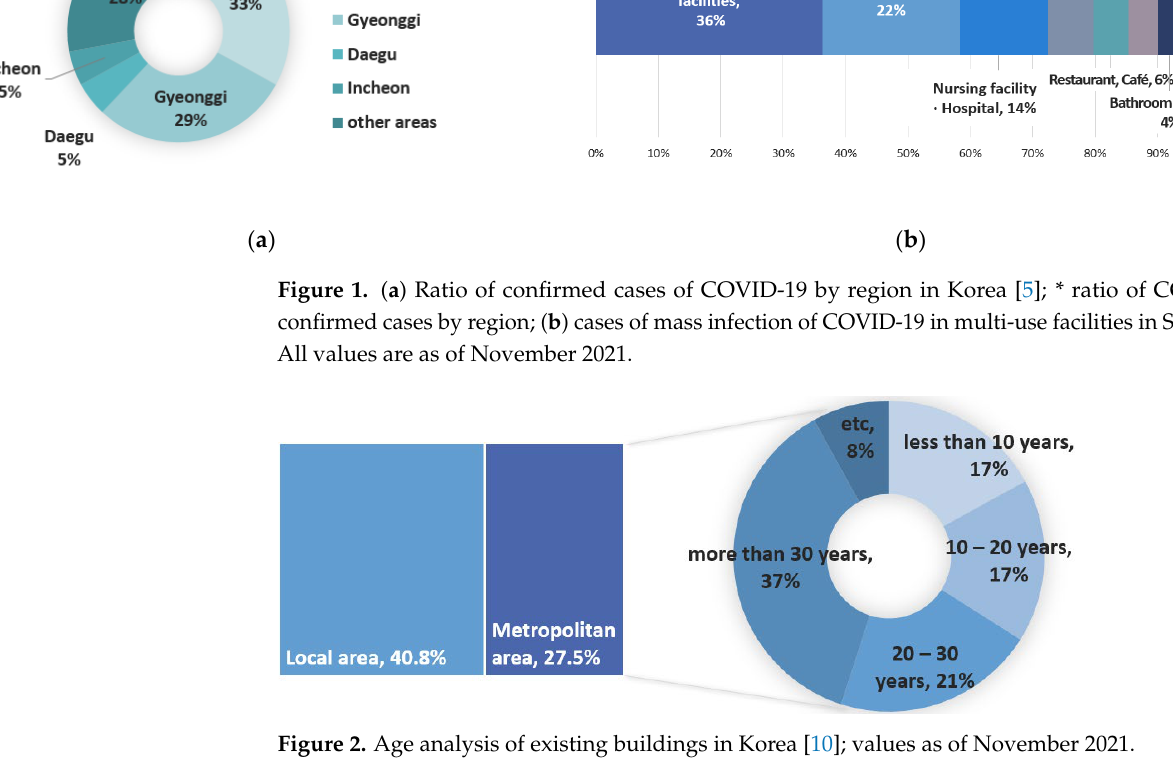
Figure 2. Age analysis of existing buildings in Korea [10]; values as of November 2021.